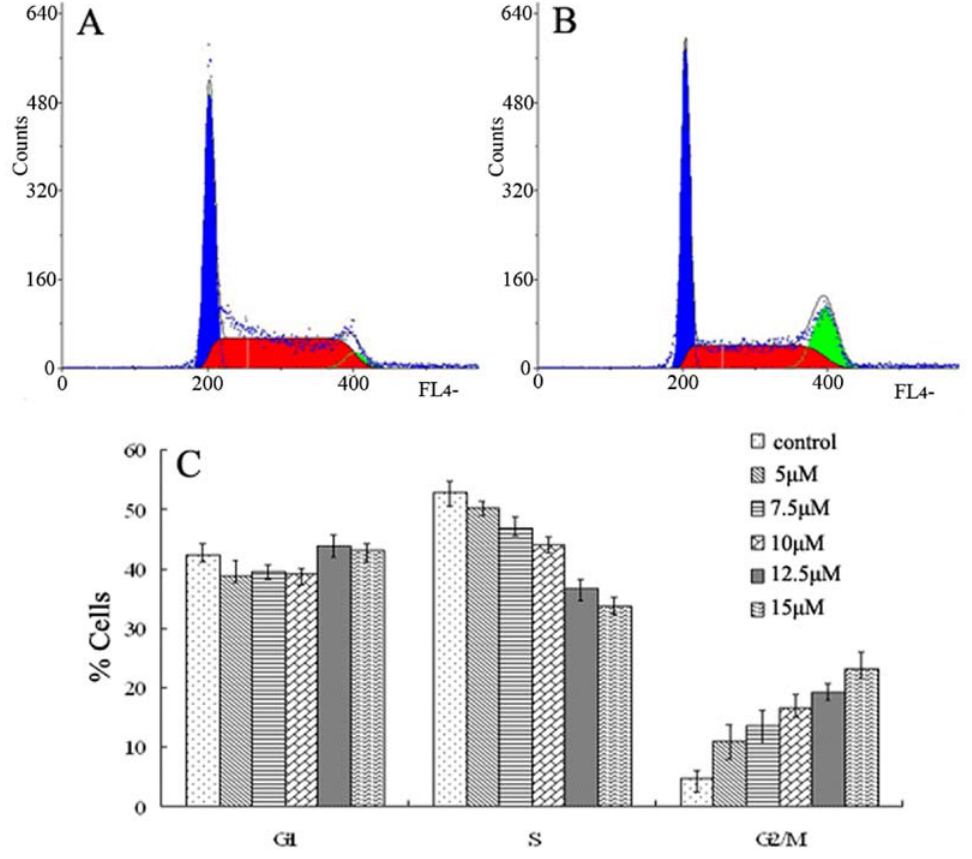
Figure 4. Cell cycles distribution of CCRF-CEM cells after treatment with different concentrations of curcumin for 48 h. Flow cytometric analysis of CCRF-CEM cell cycle distribution, (A) Untreated control cells; (B) Cells treated with 15 µM curcumin; (C) The results were analyzed by Mod Fit LT 3.0. Data are presented as mean ± SD (n = 3). **p < 0.01, *p < 0.05; p value compared with the control group (0 µM).